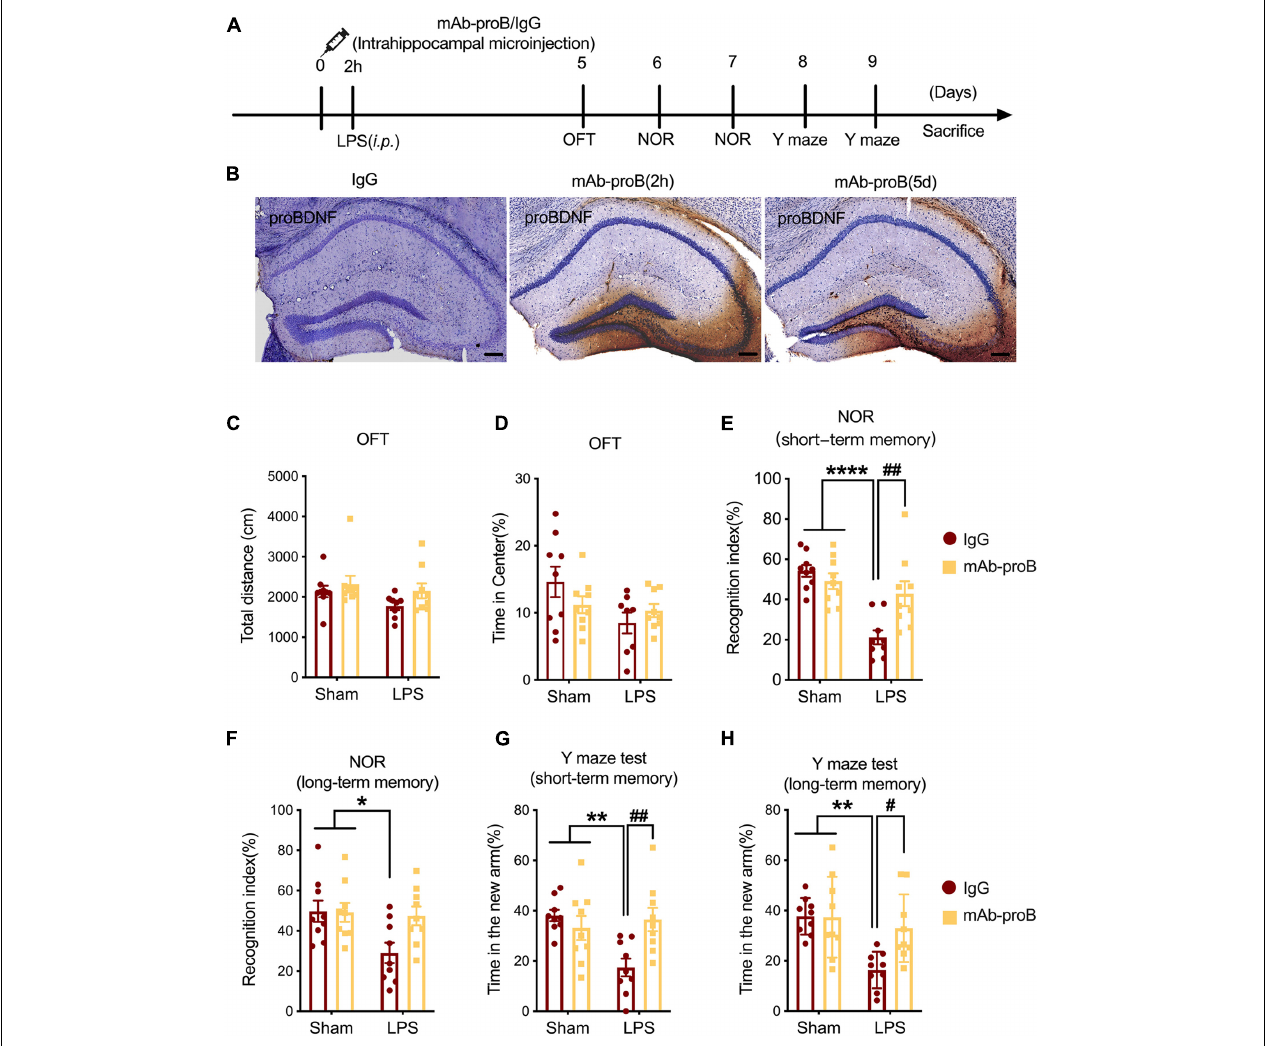
FIGURE 4 | Intrahippocampal microinjection of mAb-proB improved the sepsis-associated encephalopathy-induced cognitive impairment. (A) The behavioral intervention flowchart of the experiment. (B) The efficiency of neutralizing mAb-proB in hippocampus tissue. Scale bar = 100 µ m. (C,D) The total traveled distance and percentage of time mice spent in the center of the field via open field test ( n = 9/group). (E,F) The recognition index of short/long-term memory tasks of the novel object recognition test ( n = 9/group). (G,H) The percentage of the time that mice stay in the novel arm of the short/long-term memory tasks in the Y maze test ( n = 9/group). Data are expressed as mean ± SEM. * p < 0.05, ** p < 0.01, **** p < 0.0001 vs. sham group; # p < 0.05, ## p < 0.01, LPS + IgG vs. LPS +